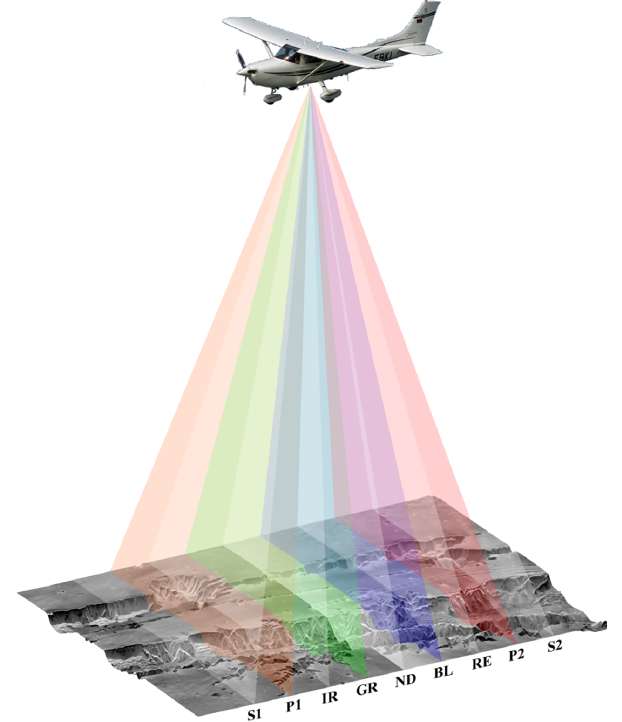
Figure B1. Operating principle of the airborne high-resolution stereo camera (HRSC-AX), and viewing geometry of the individual charge-coupled device (CCD) sensors. ND – nadir channel; S1 and S2 – stereo 1 and stereo 2; P1 and P2 – photometry 1 and photom- etry 2; IR – near-infrared channel; GR – green channel; BL – blue channel; RE – red channel. All nine line sensors have a cross-track field of view of ± 6 ◦ .